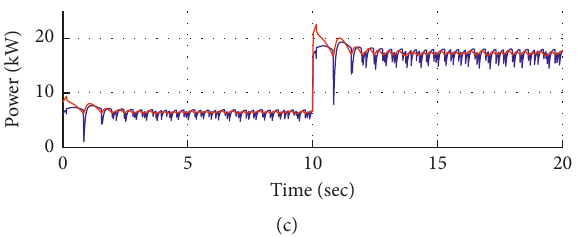
Figure 5: The (a) current, (b) voltage, and (c) generated power of the fuel cell (the proposed approach by the red line and the sliding mode approach by the blue line).